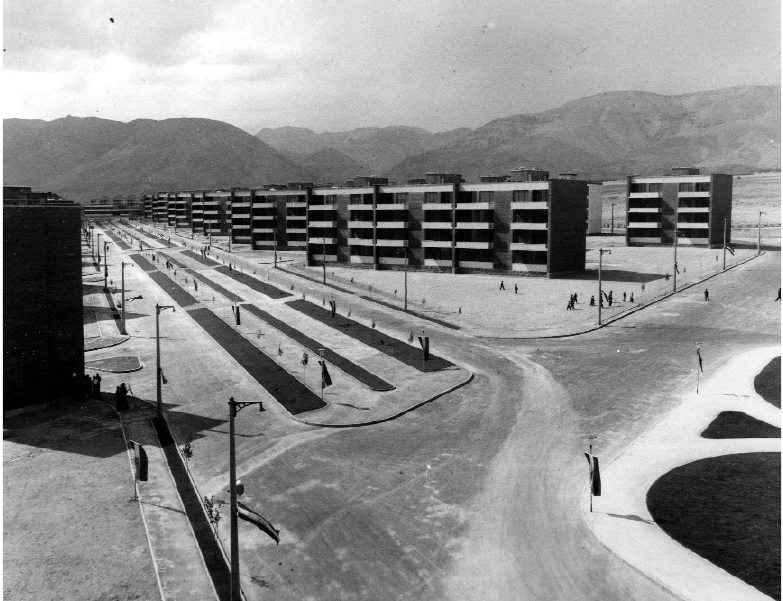
Figure 10. Kuy-e Kan, mass housing project in Tehran, 1964. Source: Iran National Library Archive (n.d.).